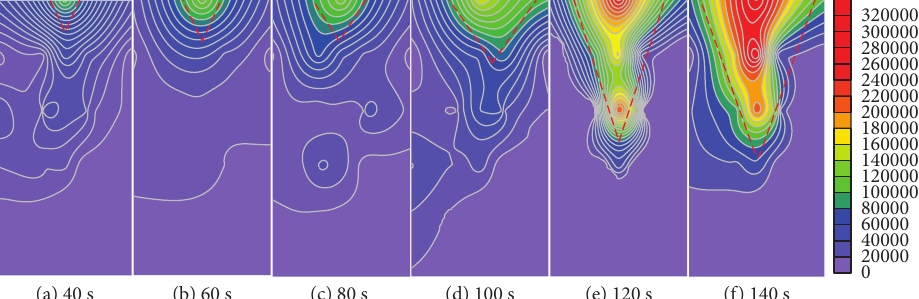
Figure 11: Electrical resistivity distribution in the rock specimen at various ultrasonic vibration durations. (a) 40s. (b) 60s. (c) 80s. (d) 100s. (e) 120s. (f)